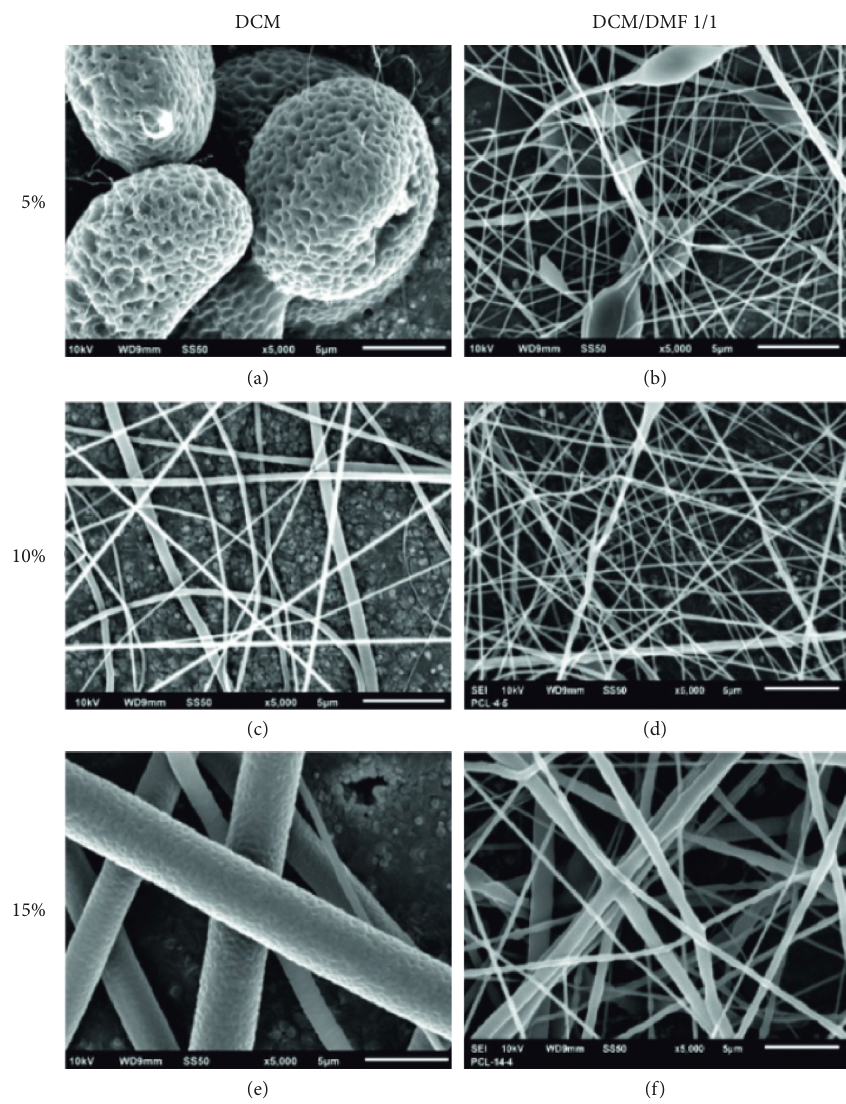
Figure 10: SEM micrographs of electrospun PCL at constant conditions: applied voltage � 10kV, flow rate � 1ml/h, needle to collector distance � 15cm, and scale bar � 5 μ m (archive of